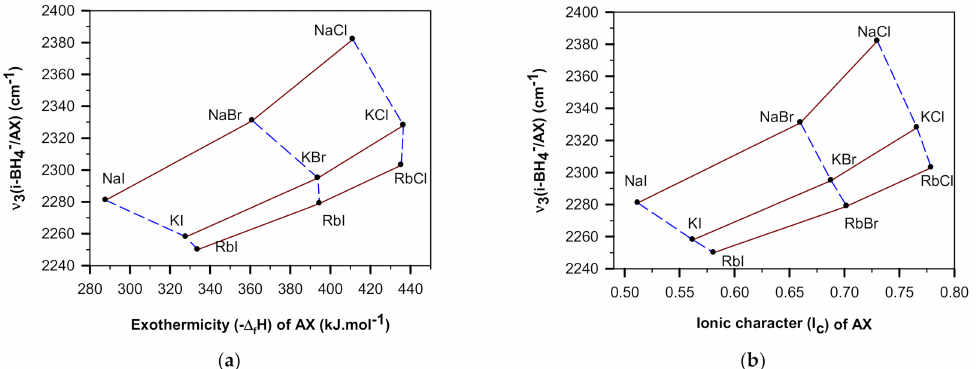
Figure 5. Graphical representation of ν 3 (i − BH 4 − ) in function of ( a ) the exothermicity (– ∆ f H) of AX and ( b ) the ionic character (I c ) of the bond for AX halides. Red solid lines are for A − series and blue dashed lines are for X −